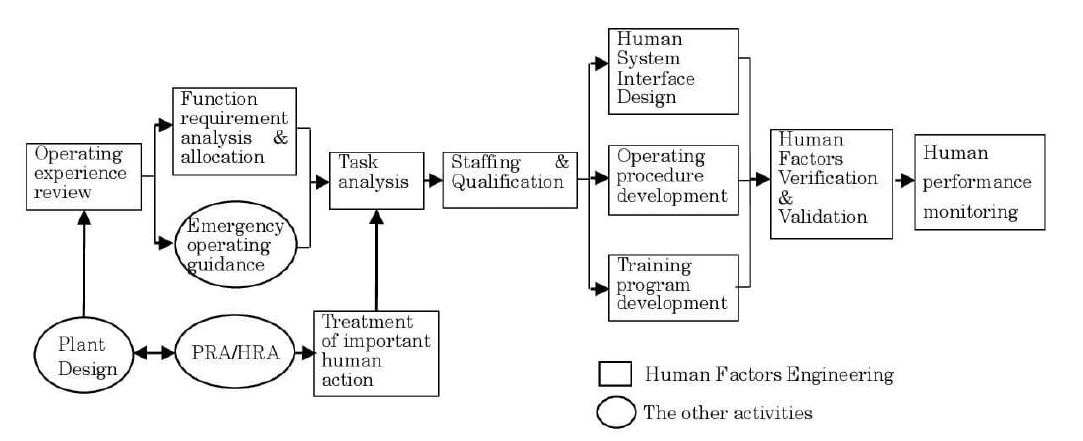
Figure 1. HFE process (U.S.NRC,